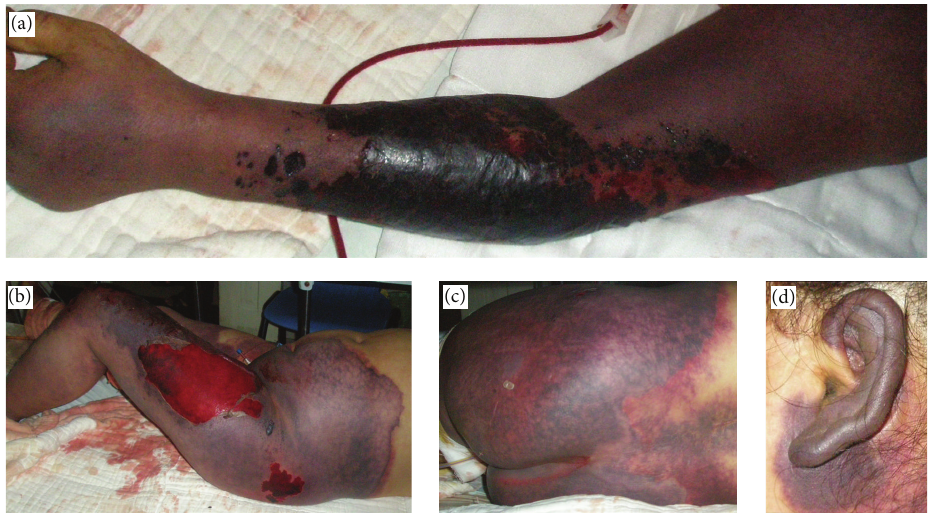
Figure 2: Photograph of the sharply developed purpura. Purpuric rash in the (a) left arm, (b) left lower limbs, (c) buttocks and (d) left